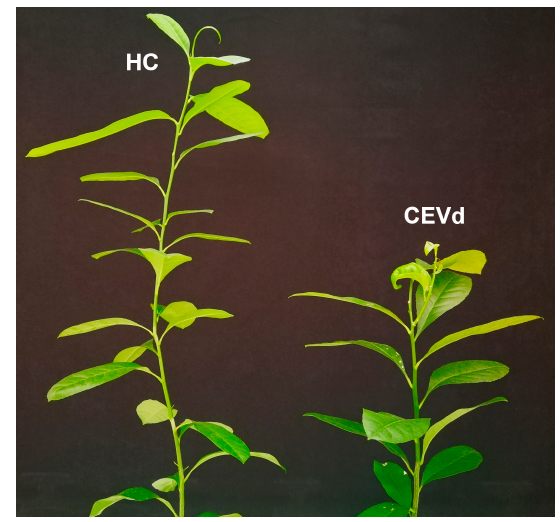
Figure 2. Disease symptoms of citron plants after grafting for 3 months. Table 1. The quality of sequencing data.